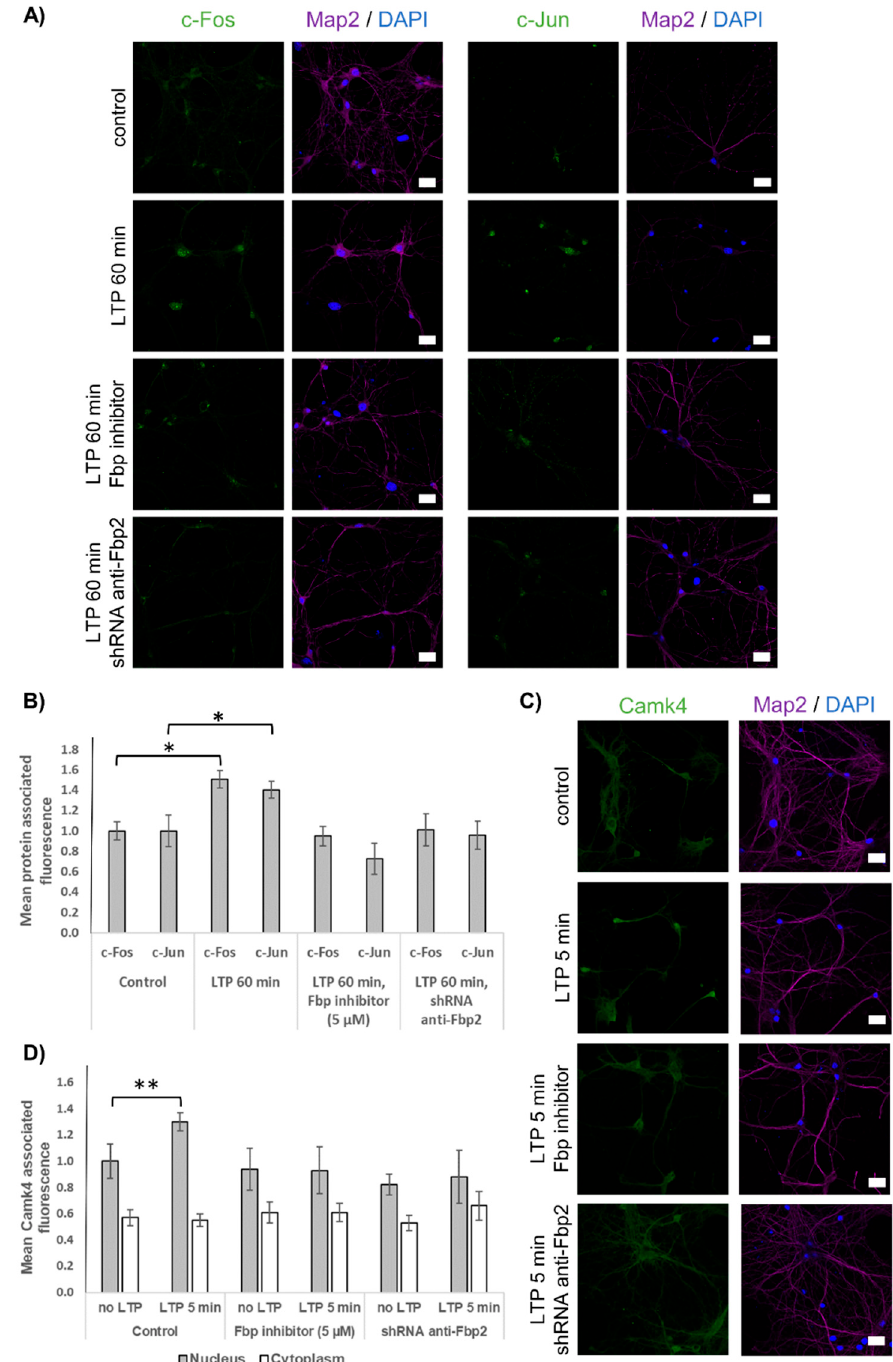
Figure 6. Expression of the late-phase LTP depends on Fbp2 structure and concentration. ( A ) Induction of LTP increases fluorescence related to c-Fos (left panel) and c-Jun (right panel); however, inhibition of Fbp or reduced concentration of the enzyme abolishes the expression of both the transcription factors. ( B ) Quantification of mean c-Fos- and c-Jun-associated fluorescence in neurons after the LTP induction as compared to the fluorescence in neurons in which LTP was not induced. For each condition, N = 30 ROIs. ( C ) Nuclear translocation of Camk4 is blocked by Fbp inhibition / tetramerization or silencing. ( D ) Mean Camk4-associated fluorescence from neuronal nuclei after the LTP induction as compared with that observed in unstimulated neurons (control). For each condition, N = 20 ROIs. Bar = 20 µ m. The values are given as a mean and SD. * indicates p < 0.05, ** indicates p <